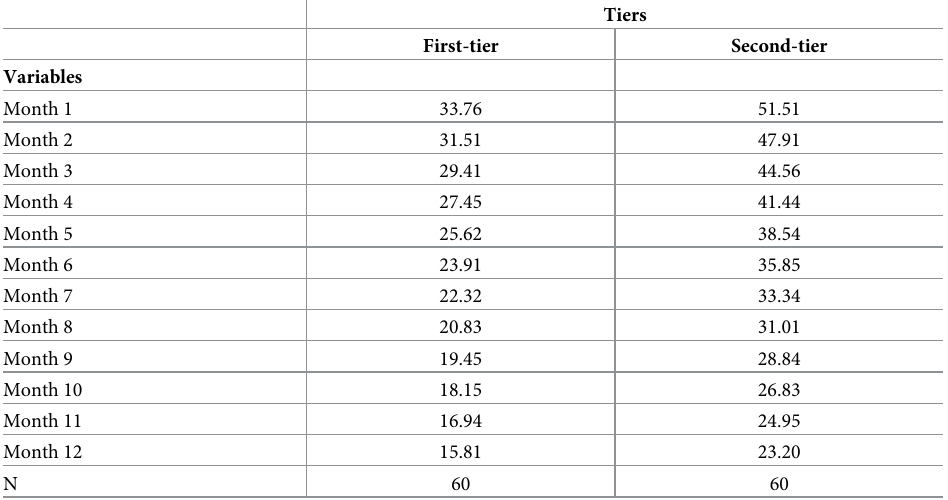
Table 4. Predicted number of players per month for first- and second-tiers